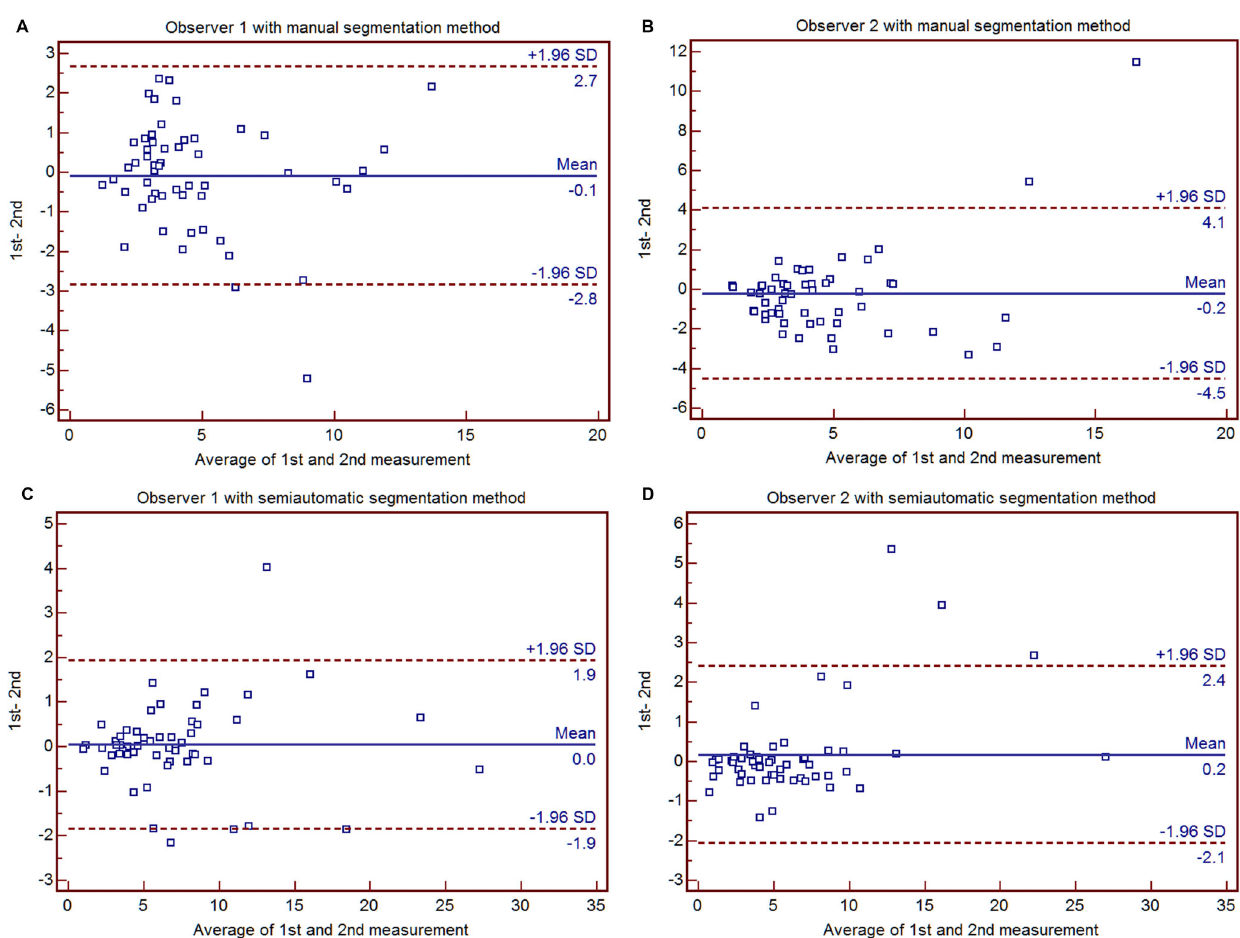
Figure 3. Bland-Altman plots show intraobserver reproducibility between the first and second measurement with observer 1 (a) and observer 2 (b) with the manual method and observer 1 (c) and observer 2 (d) with the semiautomatic segmentation method. Intraobserver reproducibility with the semiautomatic segmentation method was better than that of the manual method for both CE-T1WI- and T2WI- based evaluations. CE-T1WI=contrast enhanced T1-weighted imaging; T2WI=T2-weighted imaging.